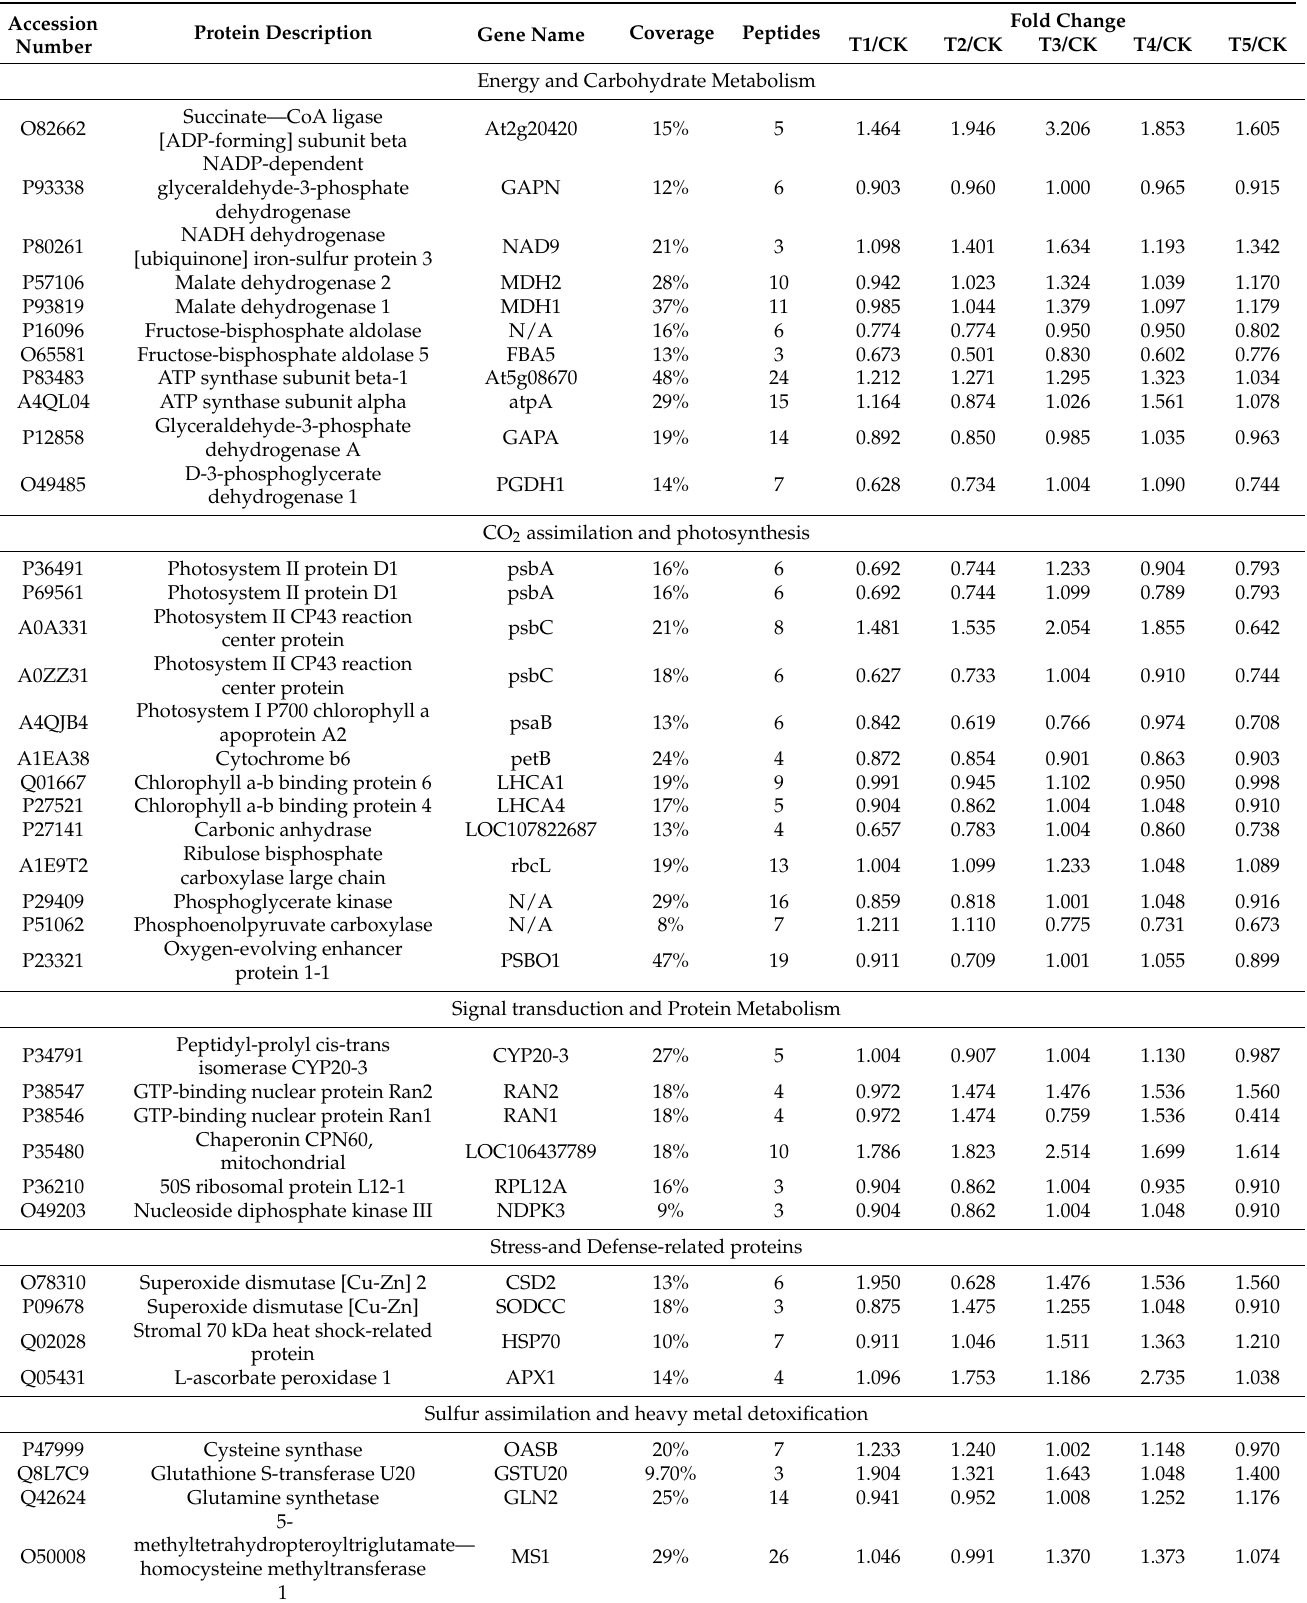
Table 1. List of differentially abundant proteins (DAPs) identified in leaves of B. napus seedlings exposed to CA-mediated Cu stress for 7